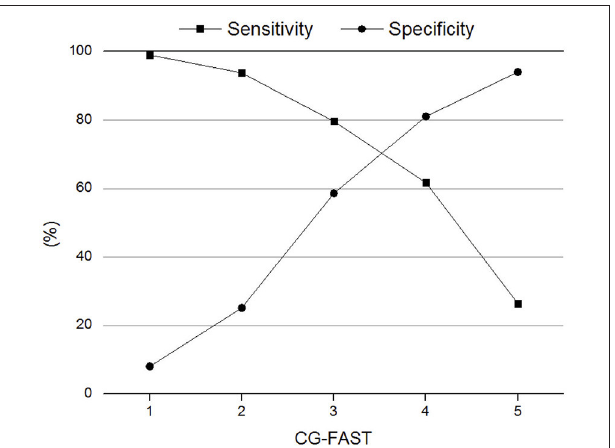
FIGURE 2 | Sensitivity and specificity of different cutoff values of the Conveniently-Grasped Field Assessment Stroke Triage (CG-FAST) scale for the detection of large vessel occlusion